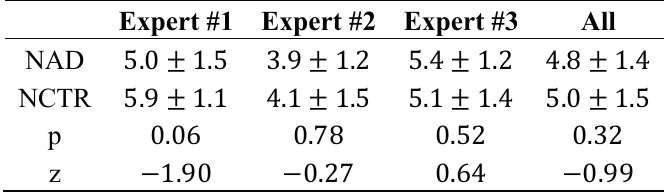
Table 1. Statistical comparison of the number of sources rejected in the group of 24 control subjects versus the group of 17 patients suffering from Alzheimer’s disease (two-sided Wilcoxon ranksum test) for each expert considered independently, and all experts aggregated. Rows indicate the number of rejected sources for AD patients (average and standard deviation), the number of rejected sources for control subjects, p-values ( p < 0.05 indicates a significant difference) and the Wilcoxon z-score